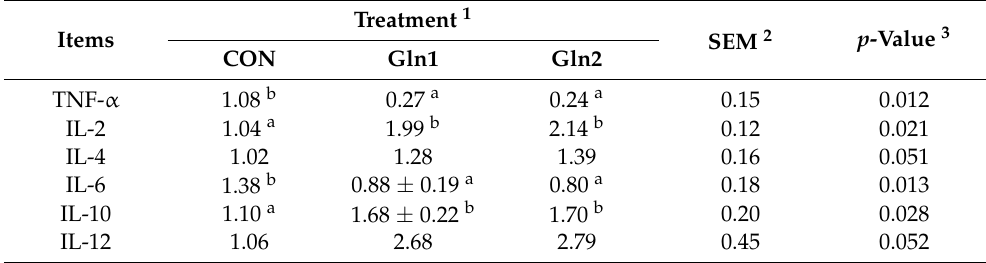
Table 6. Effects of adding Gln to high concentrate on the expression of cytokine gene in rumen epithelium of lambs.